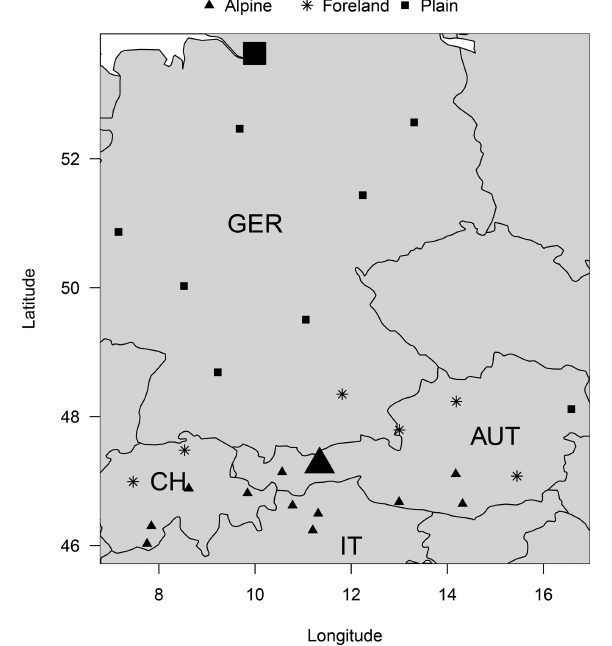
Figure 2. Study area and selected stations in Germany (GER), Switzerland (CH), Italy (IT), and Austria (AUT). The markers indi- cate stations classified as Alpine (triangle), foreland (star), and plain (square). Large symbols represent stations that are discussed in de- tail in this article: Innsbruck, Austria (large triangle), and Hamburg, Germany (large